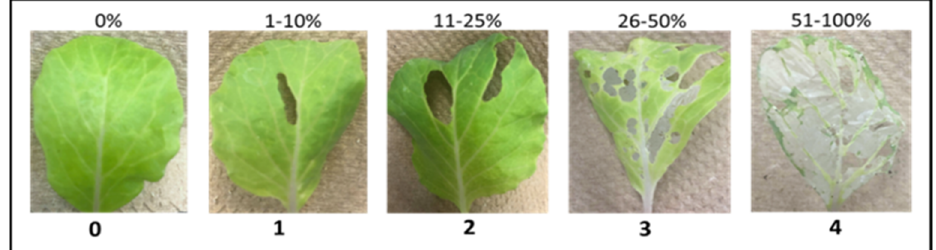
Figure 2. Damage index scale of 0–4 caused by diamondback moth or imported cabbage worm on a cabbage leaf.